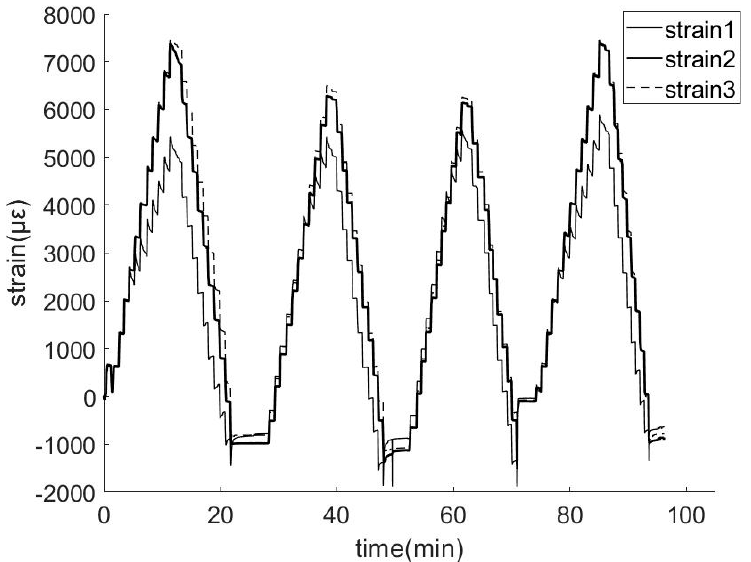
Figure 6. Three FBG strain gauge measurements in the tensile test.